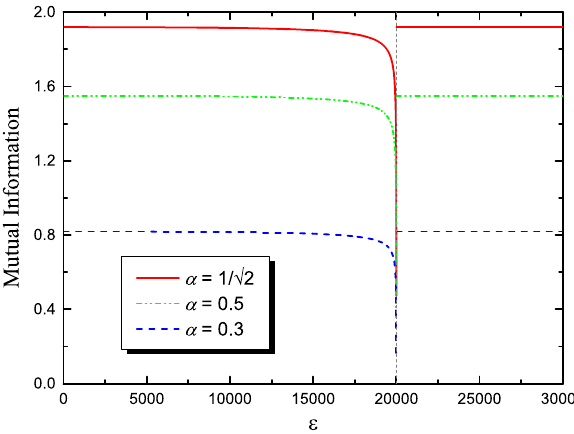
Fig. 4 The mutual information I of the final state of two entangled qubits as a function of the volume ε of the cosmic expansion. The expansion rapidity is σ = 5. The parameters of the two qubits are the same. The qubit energy level difference is (cid:15) = 2, the inner product of the mode functions, defined in Eq. (21), is μ = 0 . 1, the mass of the scalar field particle is m = 0 . 01. The initial state of the qubits is α | 01 (cid:7) + β | 10